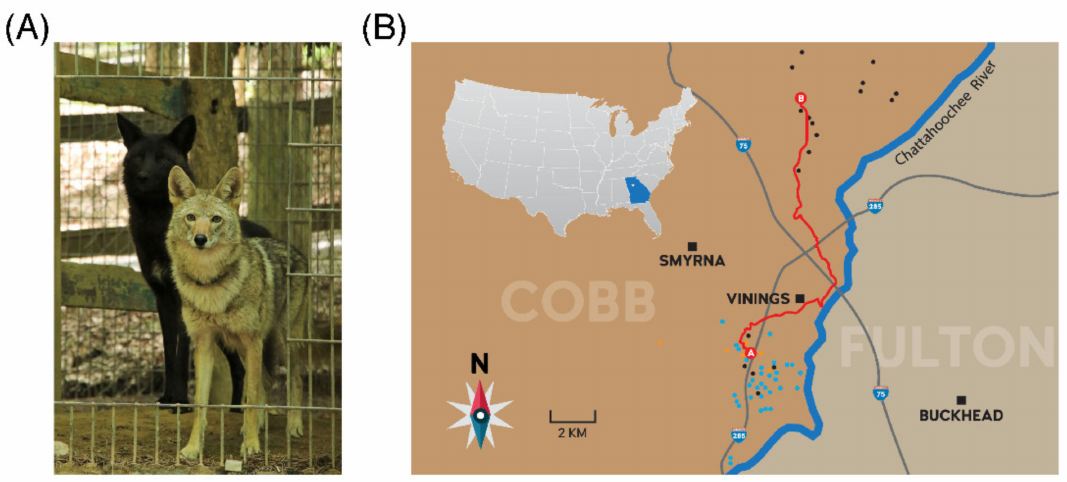
Figure 1. ( A ) Carmine (melanistic coyote; left) and Wilee (agouti coyote; right) at the Yellow River Wildlife Sanctuary after Carmine’s capture. ( B ) Map of publicly reported Carmine sightings in Cobb County, GA in December 2019 (yellow) and January (blue) and February (black) 2020. The red line represents the likely route taken by Carmine between 6 February ( A ) and 7 February ( B )